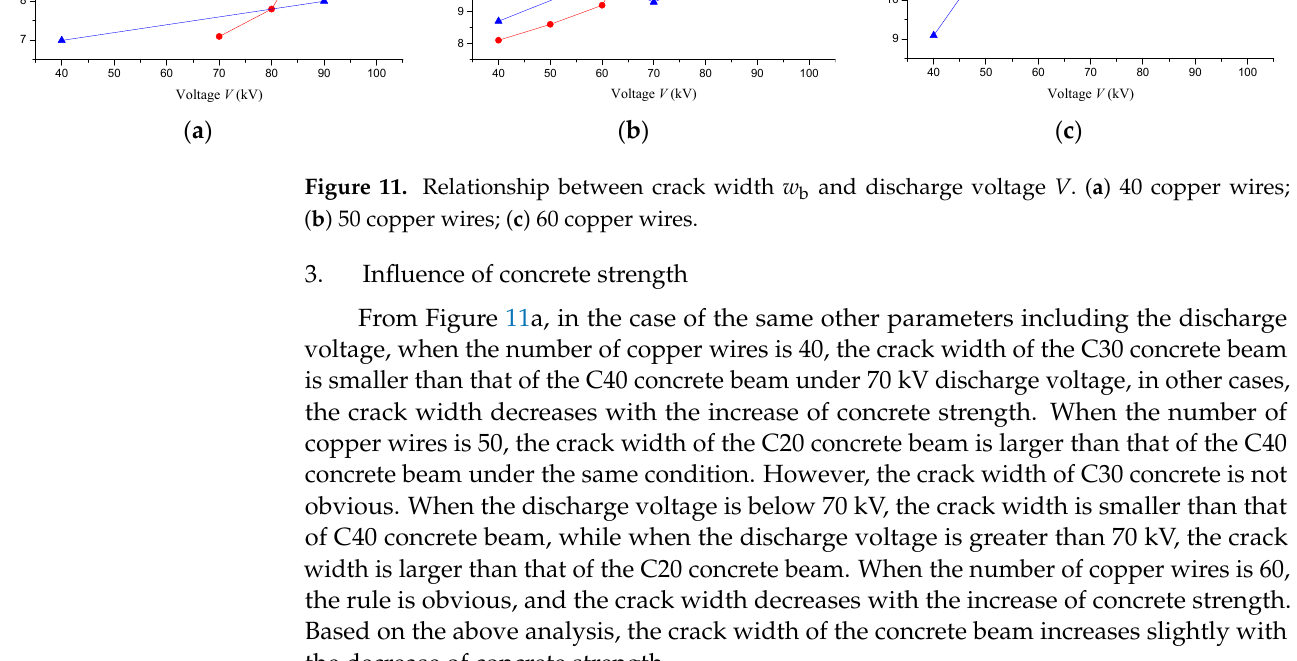
Figure 12. Relationship between crack width w b and number of copper wires n . ( a ) Concrete C20; ( b ) Concrete C30; ( c ) Concrete C40. 3.2. Expression of Breaking Effect According to the above test results, three-dimensional fitting surfaces of crack width w b , number of copper wires n and discharge voltage V of the concrete beam side surface of concrete strength grade with hole diameter of 40 mm and hole spacing of 300 mm and 400 mm are formed, as shown in Figures 13 and 14.